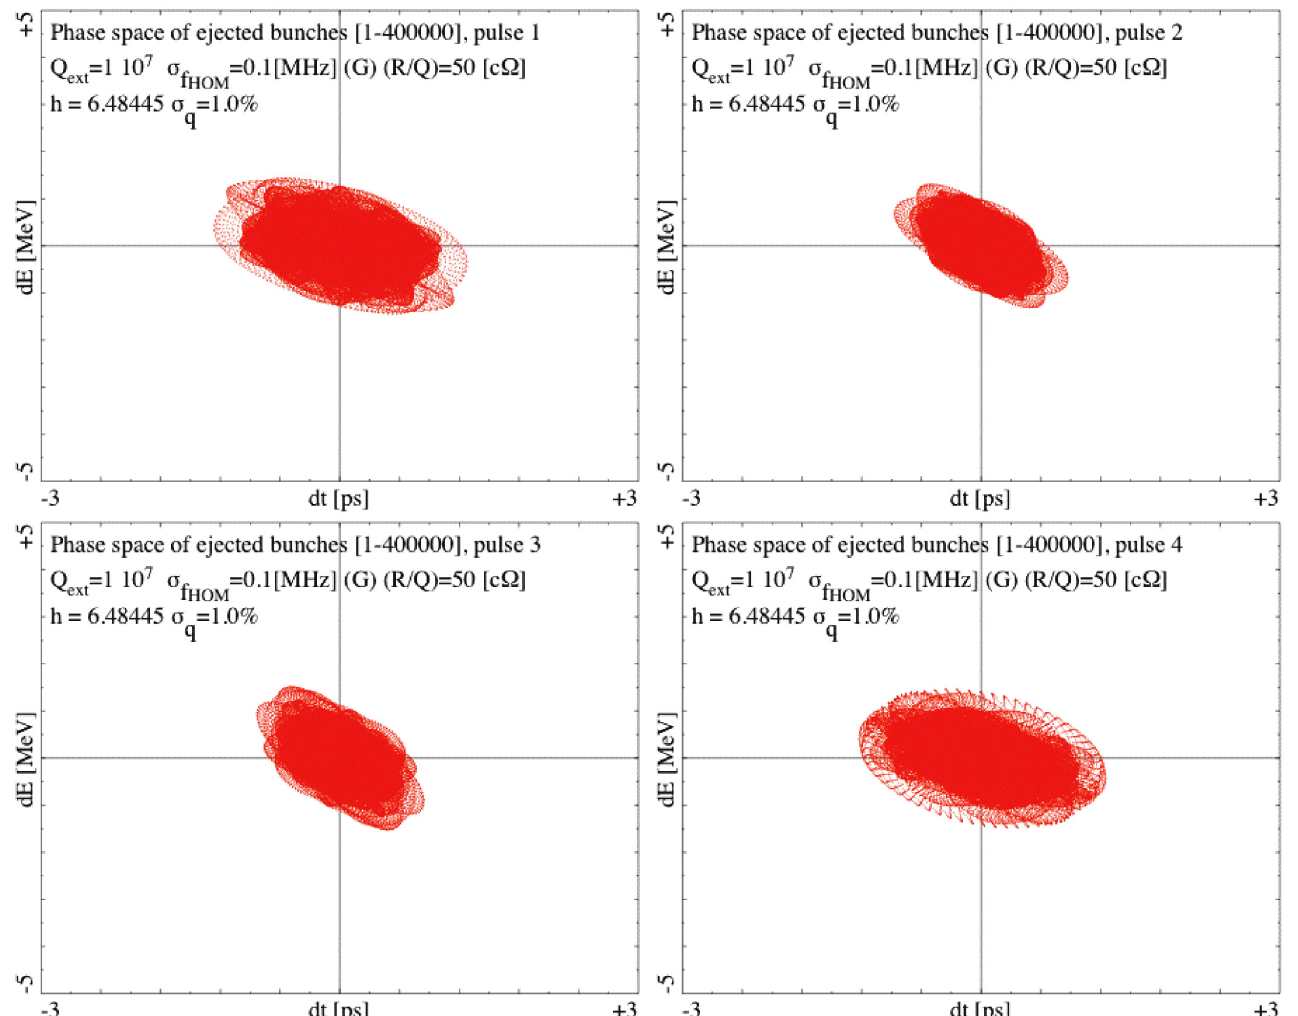
FIG. 13. (Color) Phase-space plots for four statistically independent bunch-charge sequences.